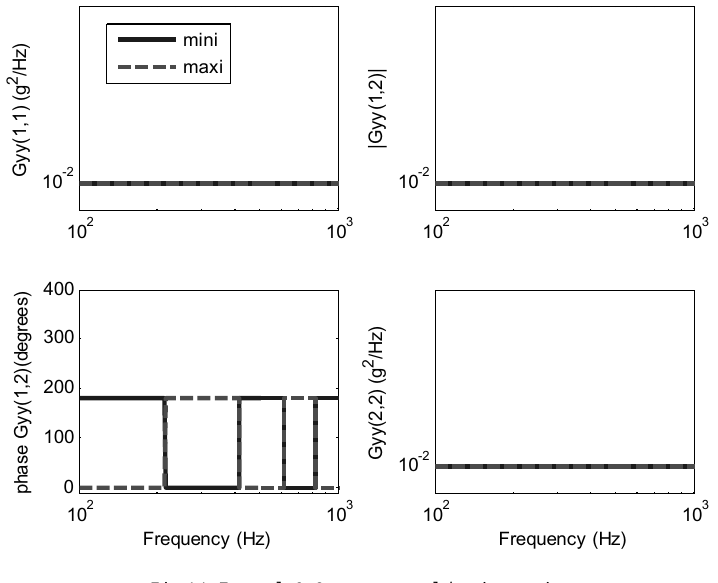
Fig. 14. Example 3, Output spectral density